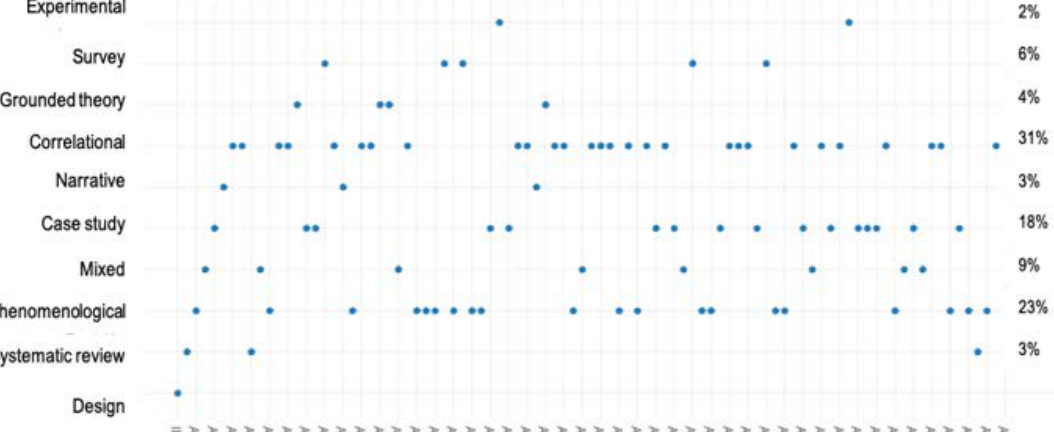
Figure 6. Designs of educational research used in the documents. Table 7 identifies the sets of documents belonging to each research design. For this analysis it is important to highlight that the titles and abstracts of all documents were read. The method sections of only 36 documents (those that were available in their full-text version), were also read.